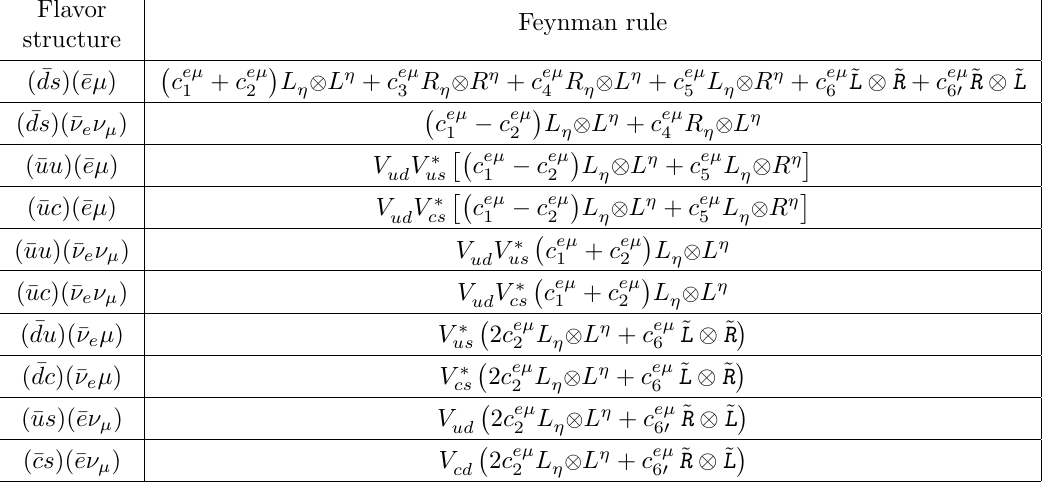
Table 4 . Feynman rules arising from Q e(cid:22) in eq. (1.4). In the second column, each entry is to be k multiplied by i= (cid:3) 2 np and completed with the Dirac spinors of the fermions in the (cid:12)rst column, we have de(cid:12)ned L = (cid:13) P , R = (cid:13) P , ~ L = P , and ~ R = P , and the element V (cid:17) (cid:17) (cid:17) (cid:17) L R L R to ( V ckm ) in eq. (1.3). The neutrinos being nearly massless and unobserved in decays, we ij